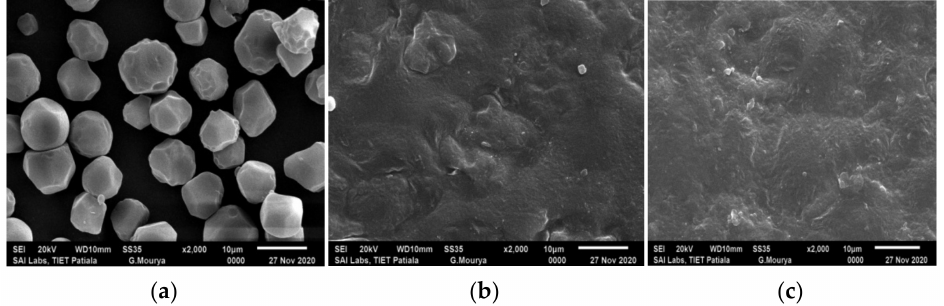
Figure 5. ( a ) Scanning electron microscopy of proso millet starch, ( b ) native film, and ( c ) starch–k- carrageenan